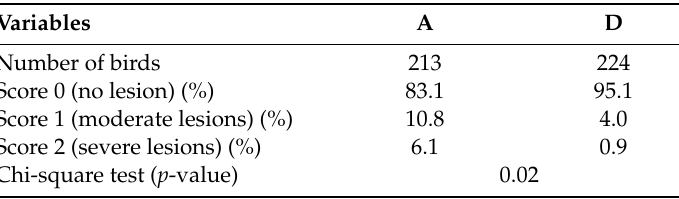
Table 5. Incidence and severity of FPD at 42 d